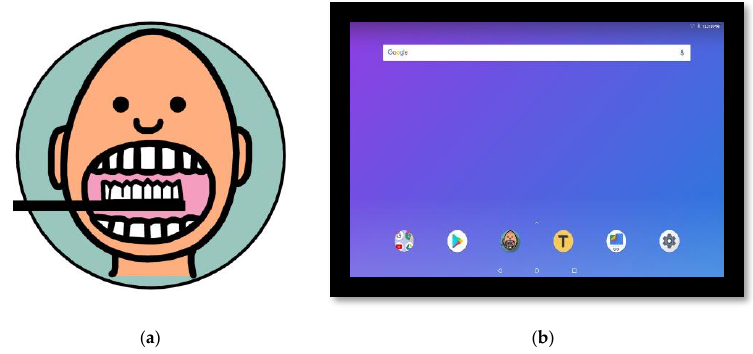
Figure 32. ( a ) WUIM-AR start button; ( b ) WUIM-AR button/icon on screen.